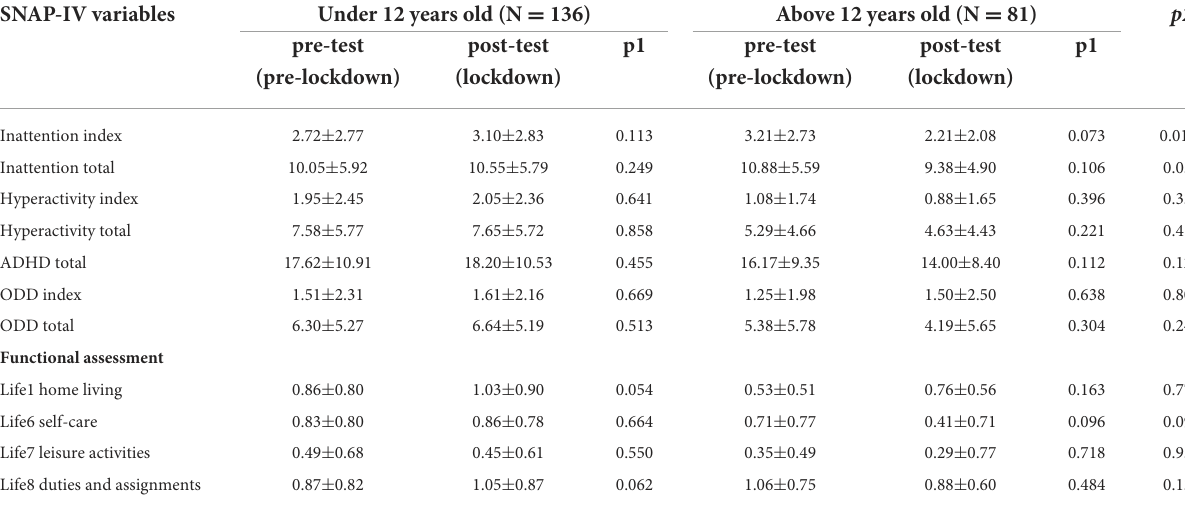
TABLE 3C Comparison of SNAP and the functional assessment of different age groups during the lockdown and pre-lockdown periods. SNAP-IV